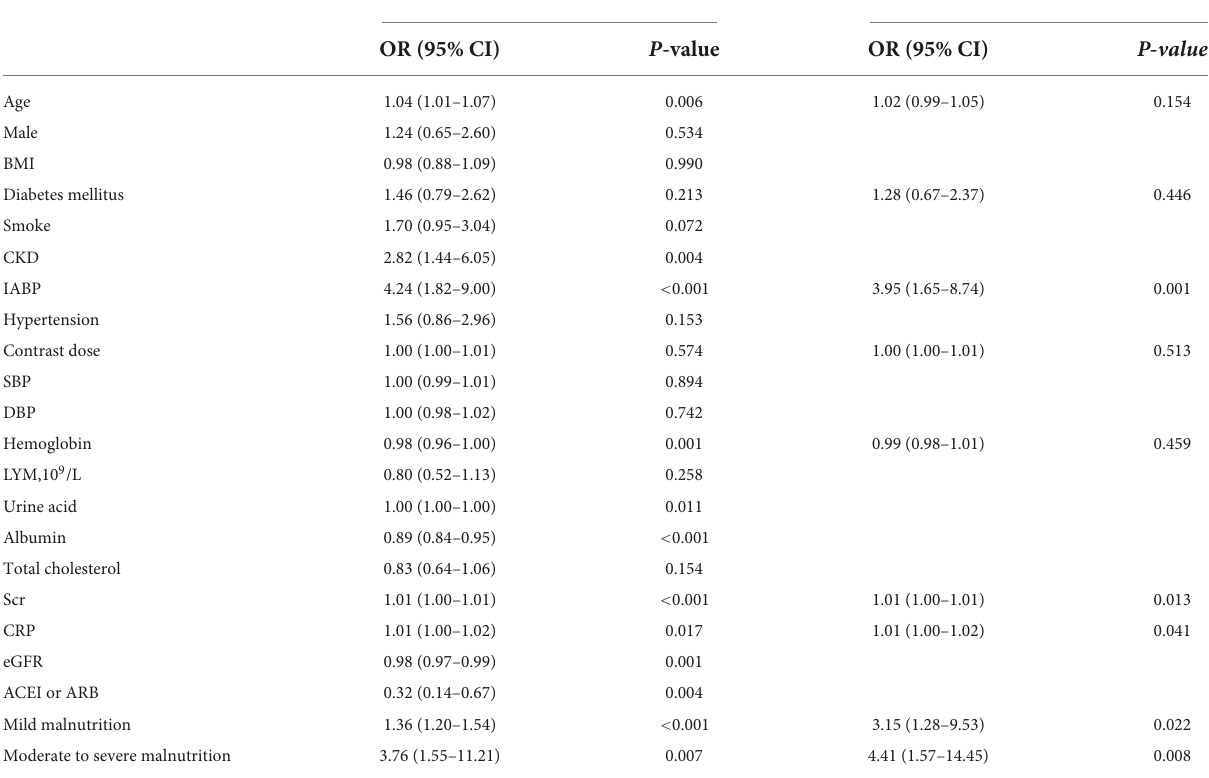
TABLE 3 Univariate and multivariate logistic regression analysis of the association between malnutrition and